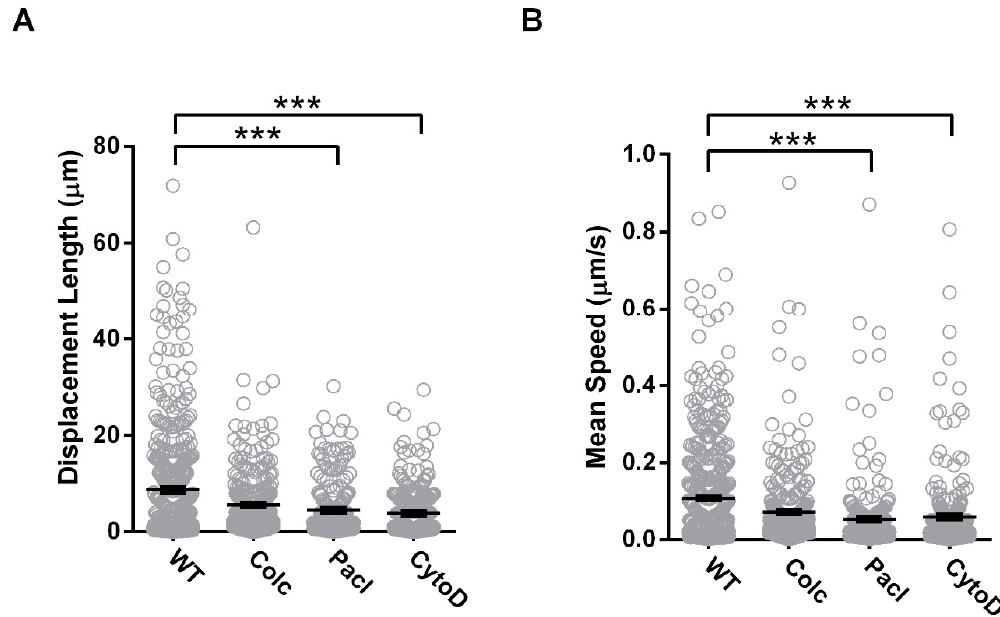
Figure 6. Transport and incorporation of Cx36 into the GJP is dependent on intact actin and tubulin cytoskeletons. Vesicular transport within the submembrane region was monitored using TIRF microscopy to determine the ( A ) displacement ( µ m) and ( B ) speed ( µ m / s) of Cx36 vesicles. Colchicine (Colc) did not significantly a ff ect Cx36 vesicular tra ffi cking. However, both Paclitaxel (Pacl) and Cytochalasin D (CytoD) treatment resulted in significant reduction in tra ffi cking when administered to Neuro-2a cells. Data are mean ± SEM; sample sizes ( n ) were n = 475 for WT, n = 294 for Colchicine, n = 215 for Paclitaxel, and n = 237 for Cytochalasin D treated vesicles. *** p < 0.0001, Kruskal–Wallis test; all samples were compared to the WT